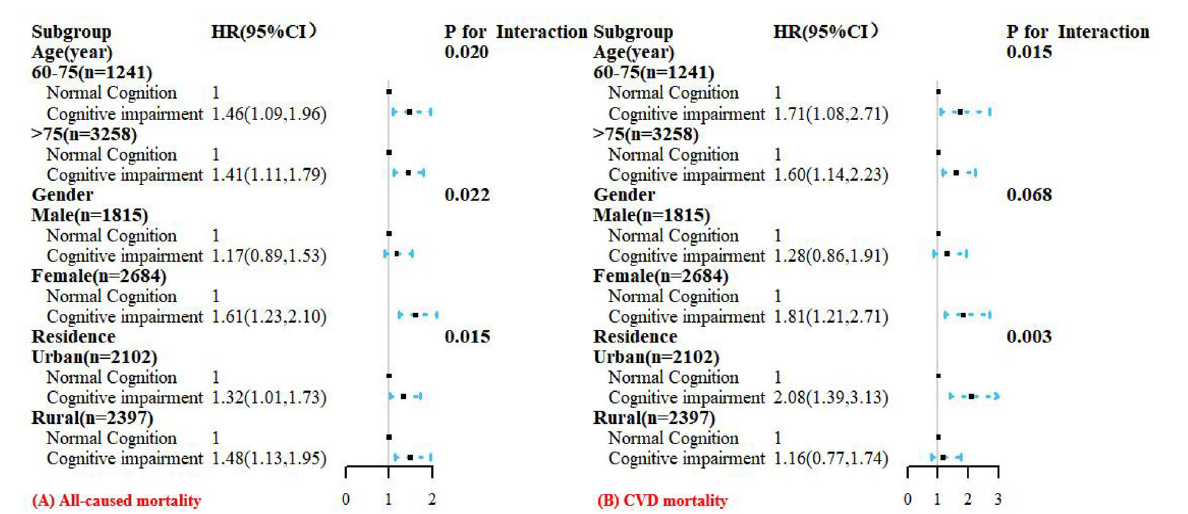
FIGURE4 Hazard ratios (HRs) for the associations between cognitive impairment with all-cause (A) and CVD (B) mortality according to age, gender, and residence subgroups. All models were adjusted for age (not in age subgroup), gender (not in gender subgroup), residence (not in residence subgroup), education, marital status, smoking status, alcohol drinking, exercise; BMI, physical impairment, dementia history, multimorbidity, WC, SBP, DBP, TG, HDL-C, LDL-C, FPG, HbA1c, and uric acid.